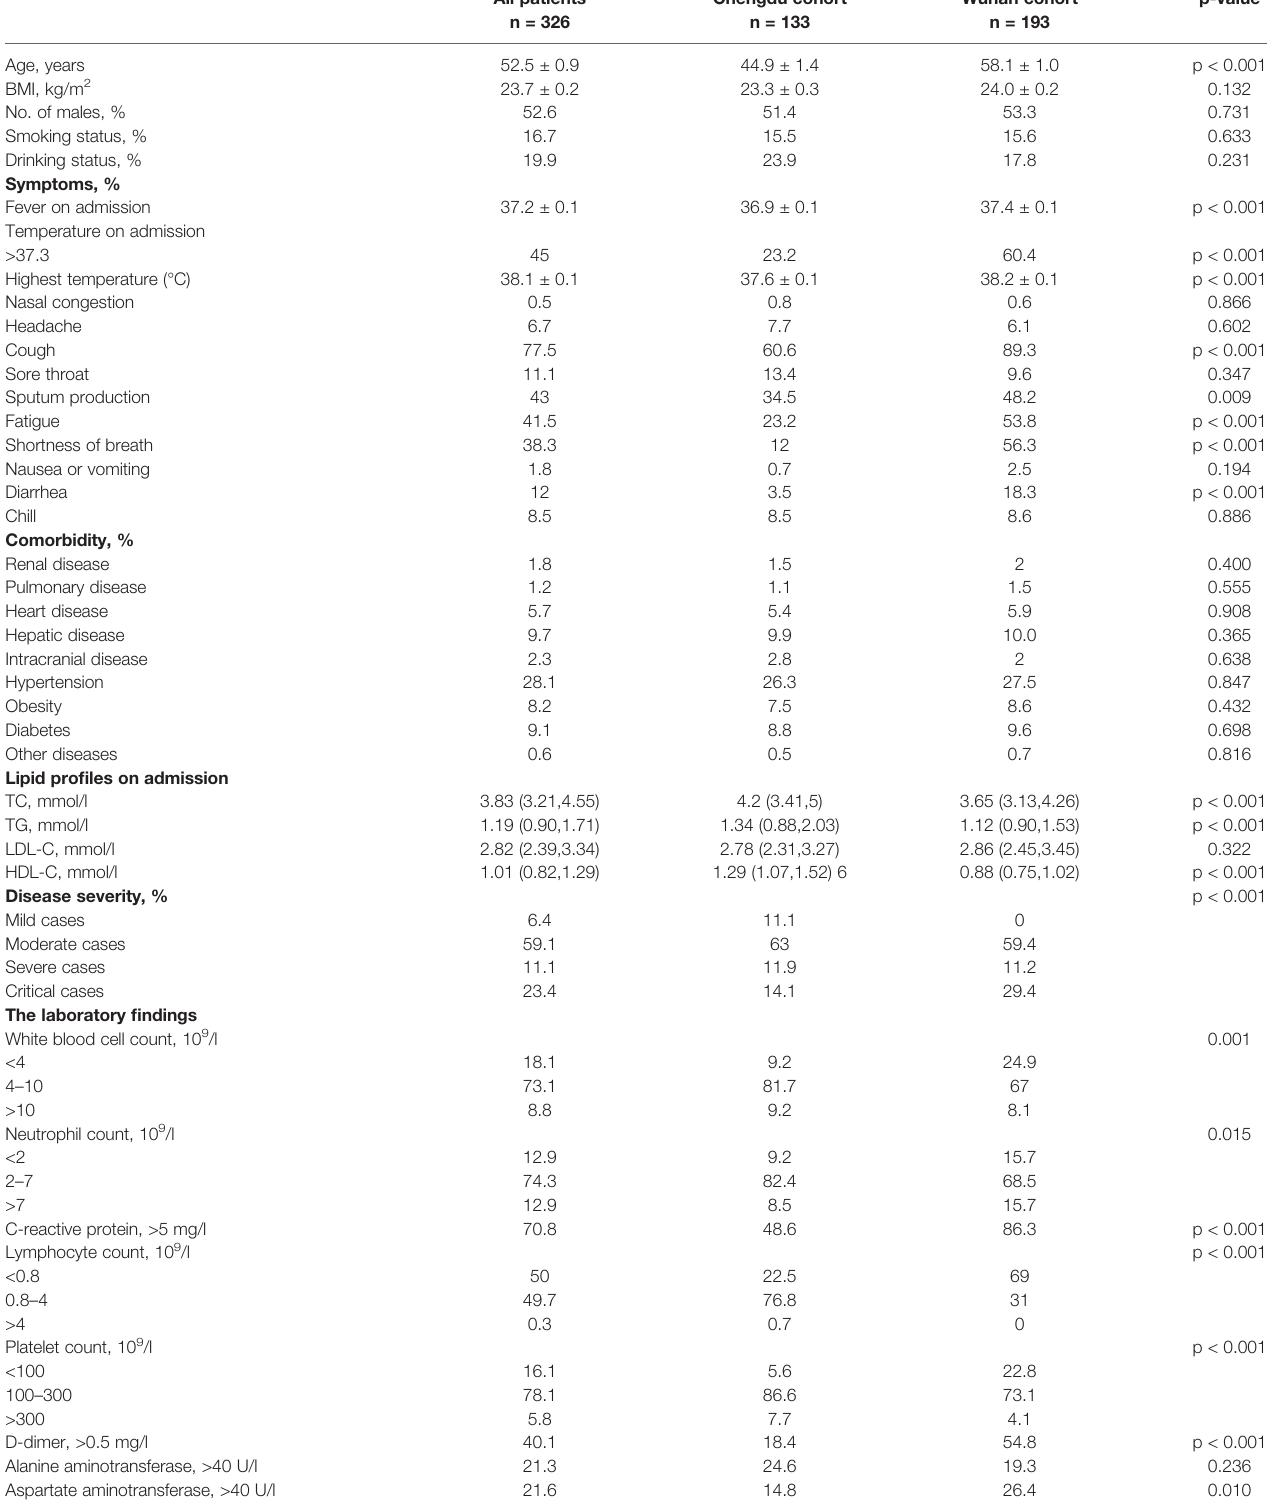
TABLE 1 | Demographic and clinical characteristics in the two cohorts. All patients Chengdu cohort Wuhan